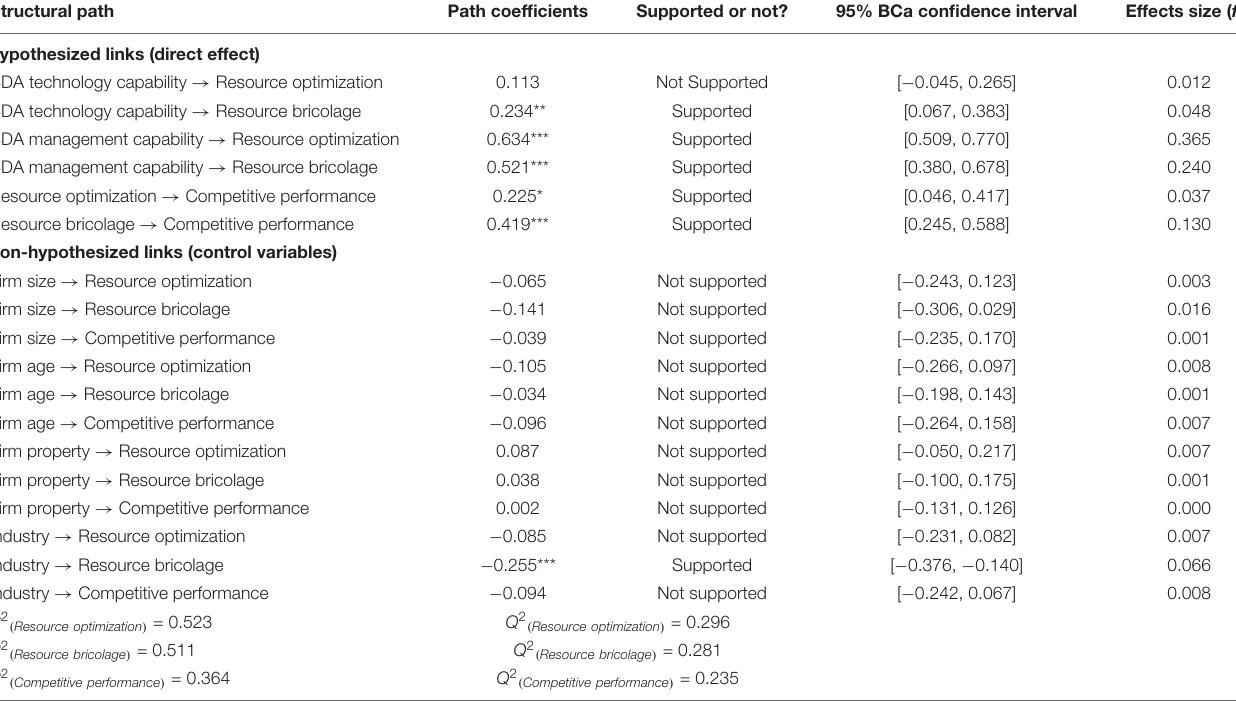
TABLE 4 | Results of path analysis ( N = 219).